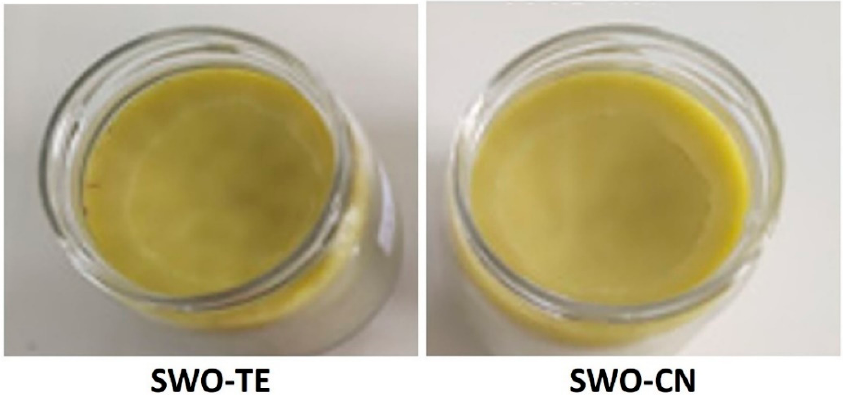
Figure 5. The prepared oleogel samples (SWO-TE: sunflower wax oleogel with thyme, SWO-CN: sunflower wax oleogel with cumin).